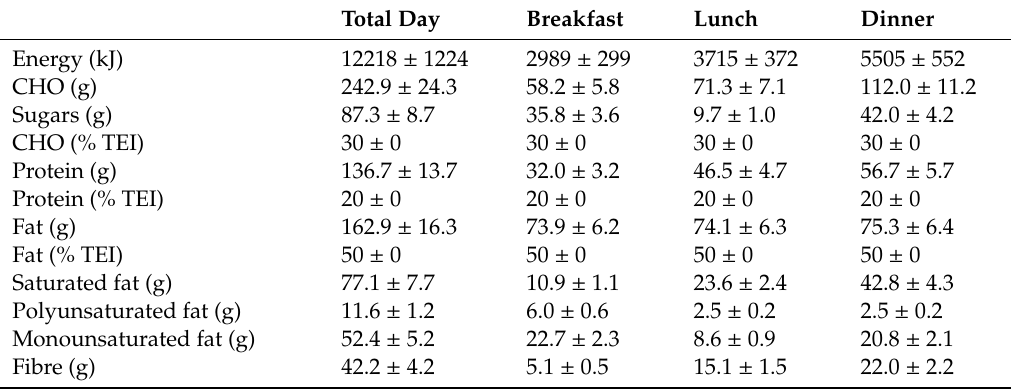
Table 1. Dietary composition of experimental diets and breakdown of meals provided to participants for 5 days in both